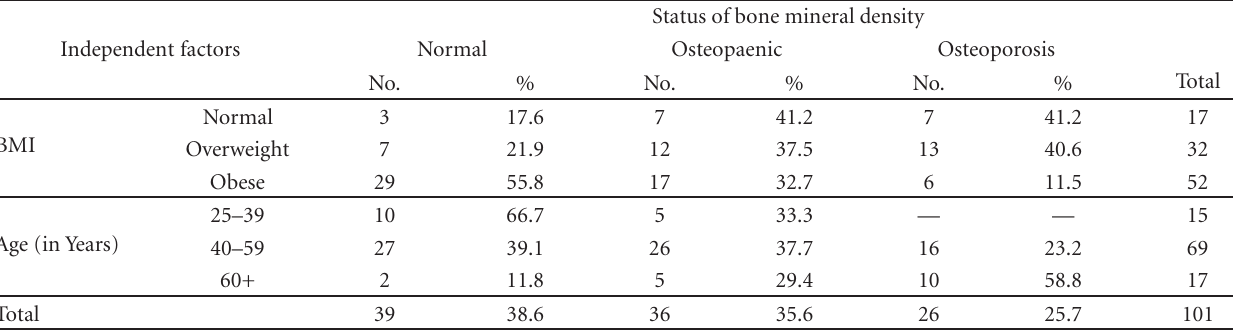
Table 2: Distribution of bone mineral density according to independent factors.